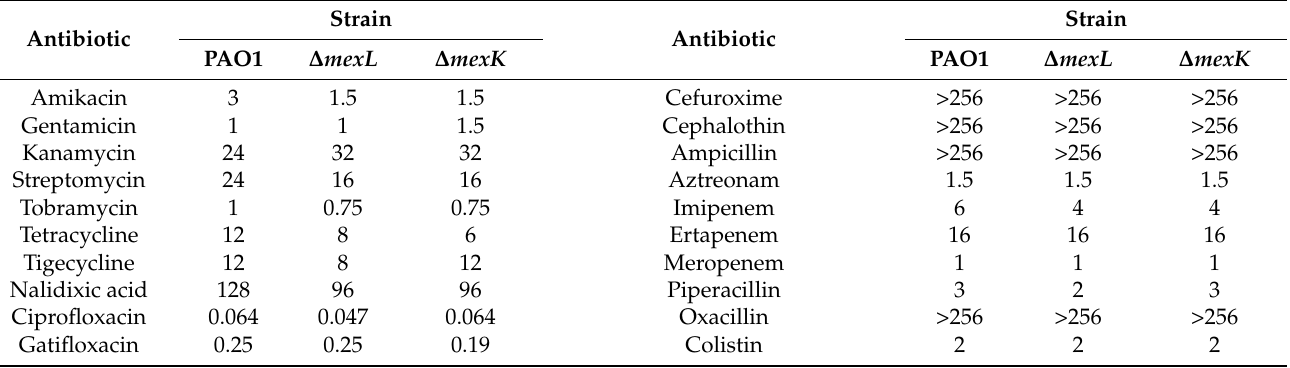
Table 1. MICs of different antibiotics for PAO1, ∆ mexL , and ∆ mexK